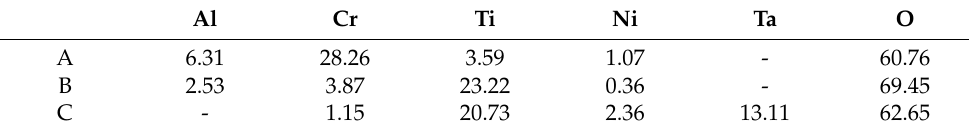
Figure 10. Secondary electron micrograph and corresponding X-ray micrograph of the E7 ( a ) and E75 ( b ) alloys after oxidation at 1000 °C for 100 h. Table 3. EDS results of the regions “A”, “B” and “C” in Figure 9 (at. %).